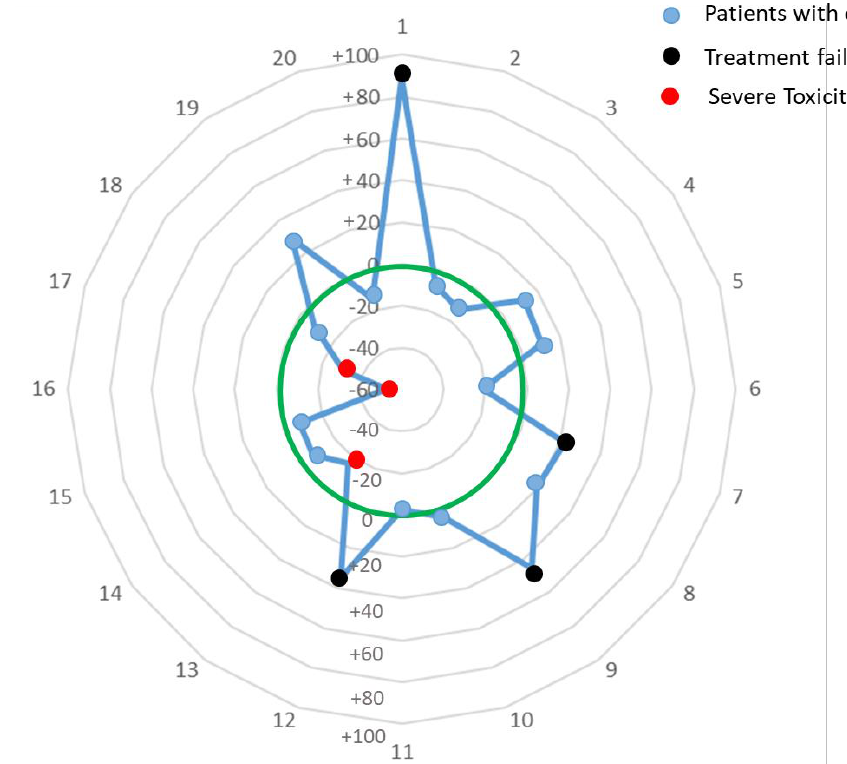
Figure 5. Model-based proposed changes (Y scale: % change as compared with initial dosage) in dosage after the first administration, and clinical outcome finally observed. Each dot represents a patient. Green Circle: No change in dosage. Outer green circle: our model proposed to increase dos- age. Inner green circle: our model proposed to reduce the dosage. The four patients with progressive disease would have all been treated with higher doses, whereas the three patients with severe tox- icities would all have been treated with a reduced dosage per model recommendations.